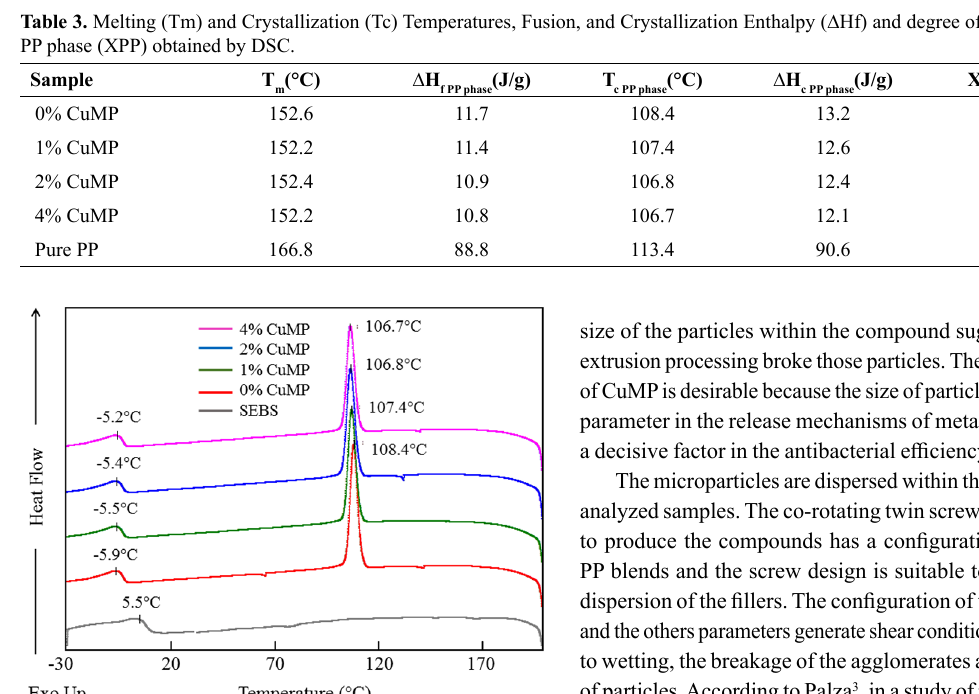
Figure 3. DSC curves of the compounds and the pure SEBS.